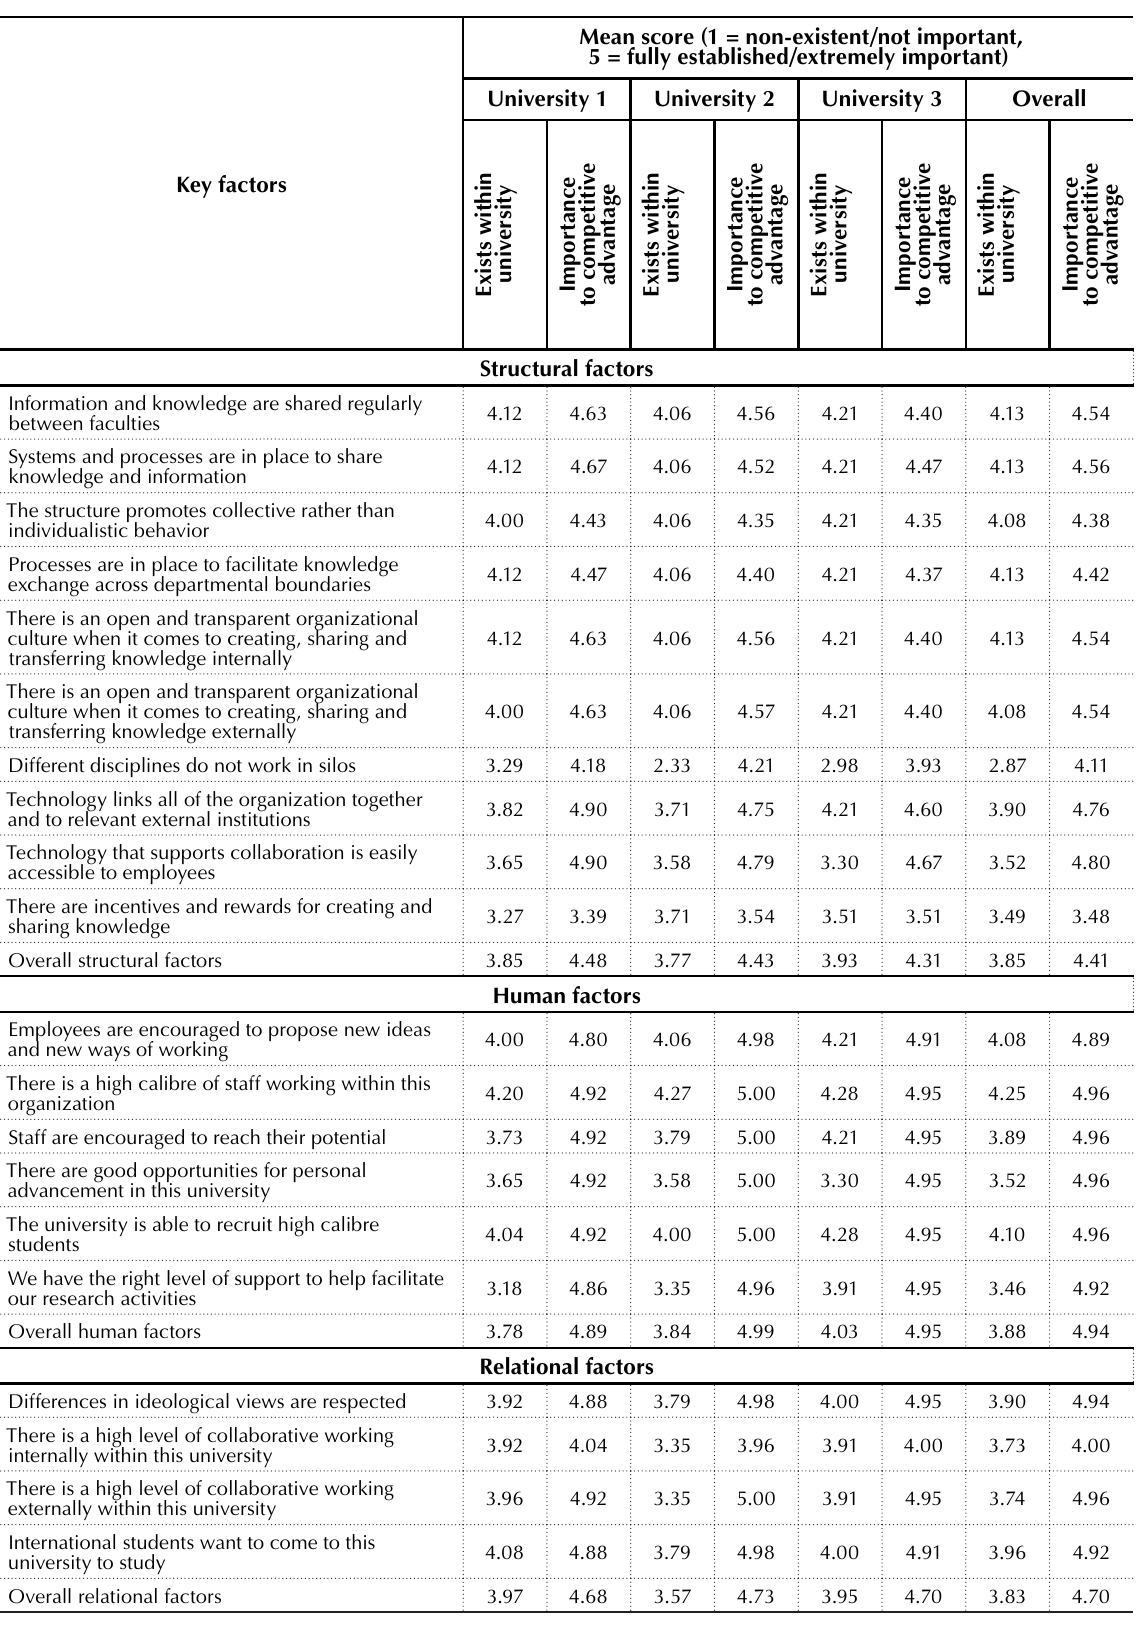
Table 5. Views on existence of key knowledge management and intellectual capital factors and their importance to contributing towards competitive advantage Mean score (1 = non-existent/not important, 5 = fully established/extremely important) University Key factors